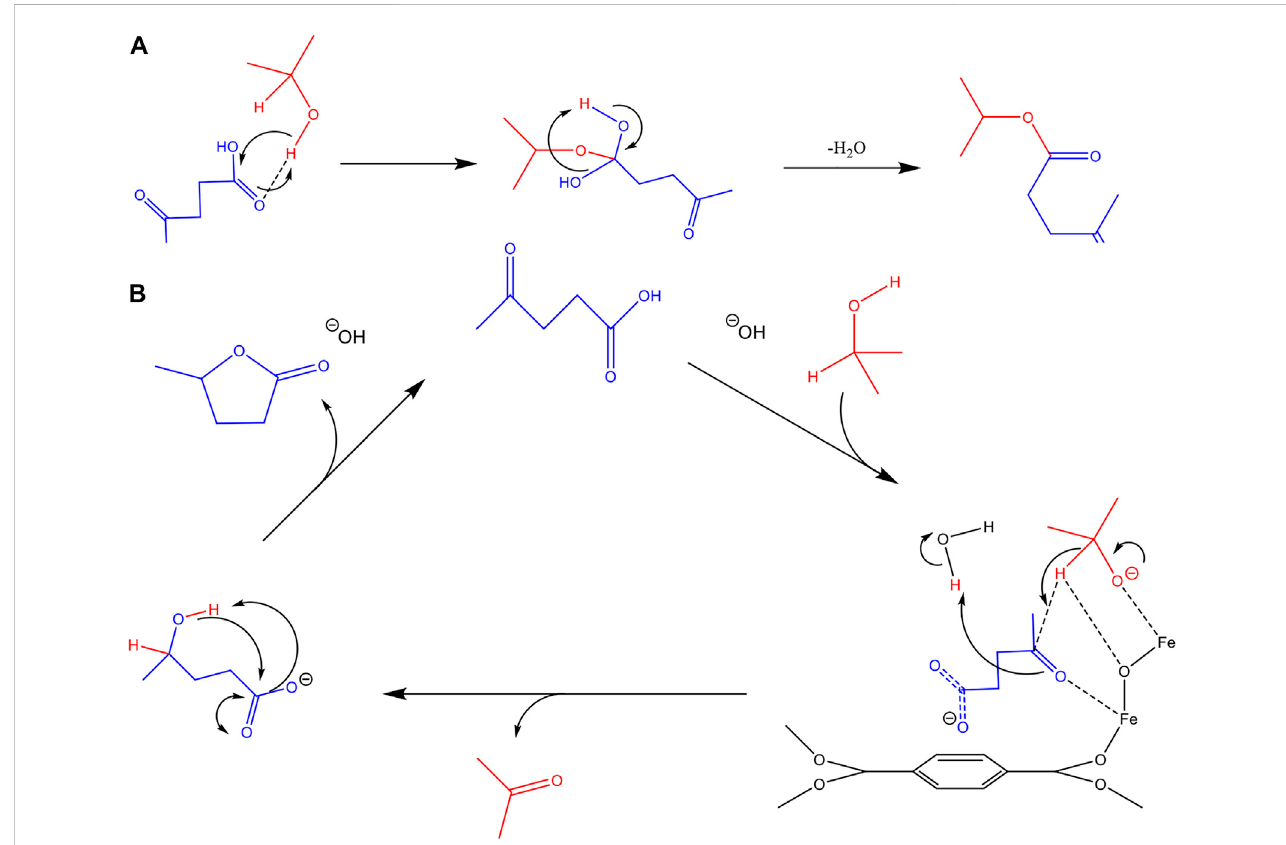
FIGURE 6 (A) Proposed conversion pathway for the side product isopropyl-levulinate, under basic conditions, absent of catalytic material. (B) A proposed reaction mechanism for the TFH of LA in the presence of active catalytic material, in this case